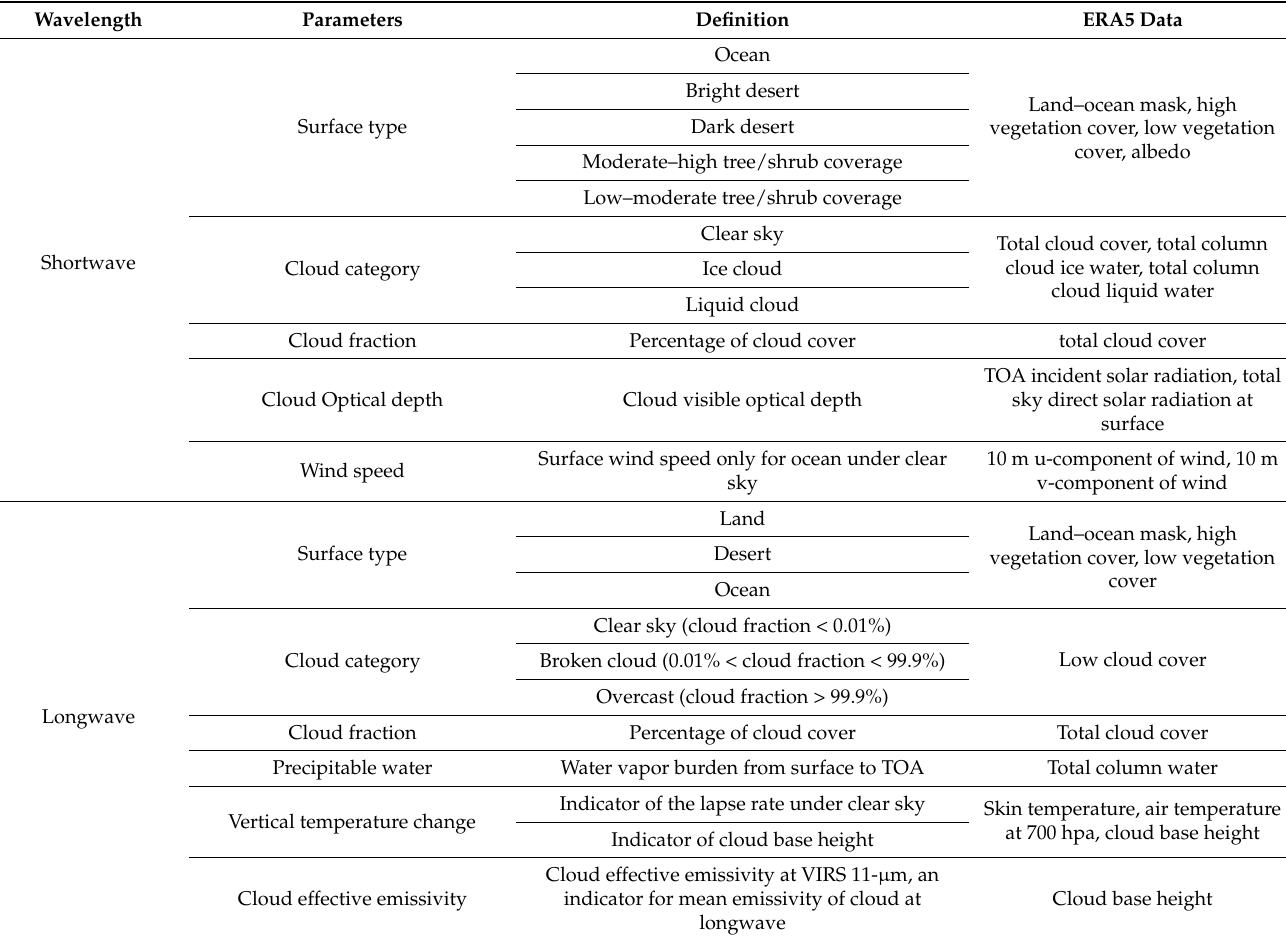
Table 2. The surface and atmosphere parameters used in the scene type of CERES/TRMM ADMs.